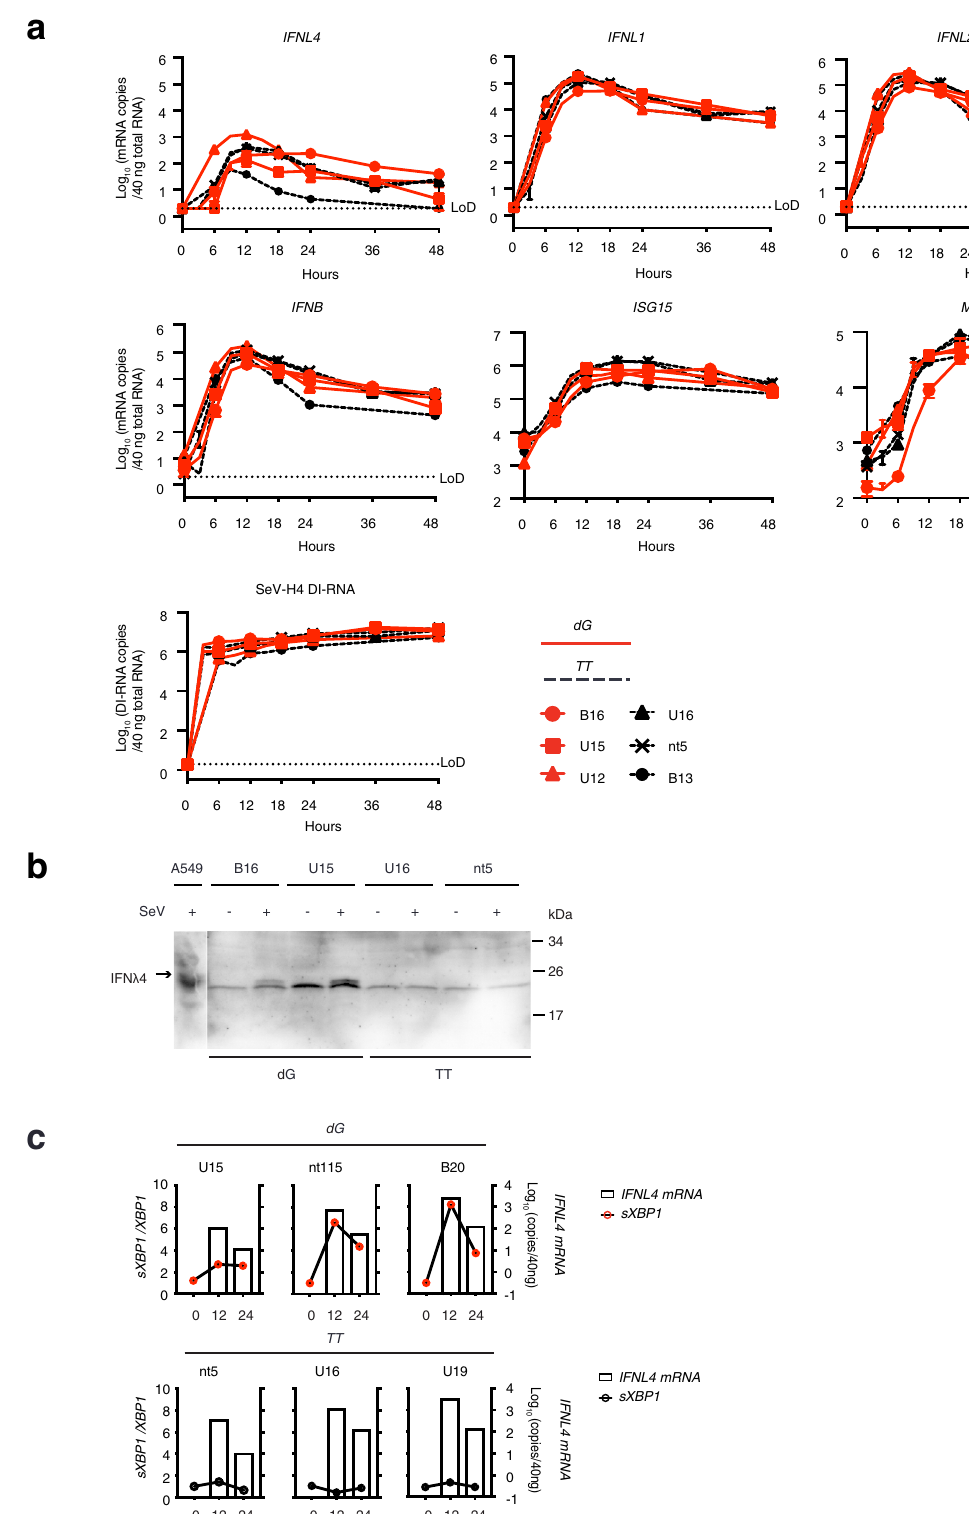
IFN λ 4 expression inhibits HCV peptide-speci fi c CD8 + T cell presentation, and thereby reduce the activation of HCV- activation . Cytosolic antigens presented by MHC-I are pri- speci fi c CD8 + T cells. To address this question, we made use marily derived from proteasomal cleavage of proteins into of a unique in vitro cell coculture system consisting of sub- peptides that are then imported into the ER and loaded onto genomic HCV replicon cells stably transduced with HLA-A2 newly synthesized MHC-I 25 . Thus, we hypothesized that the (Huh7 A2 HCV EM ) and an HLA-matched HCV-speci fi c CD8 + IFN λ 4-induced ER stress could interfere with HCV antigen T cell clone 26 . NATURE COMMUNICATIONS| (2021) 12:4882